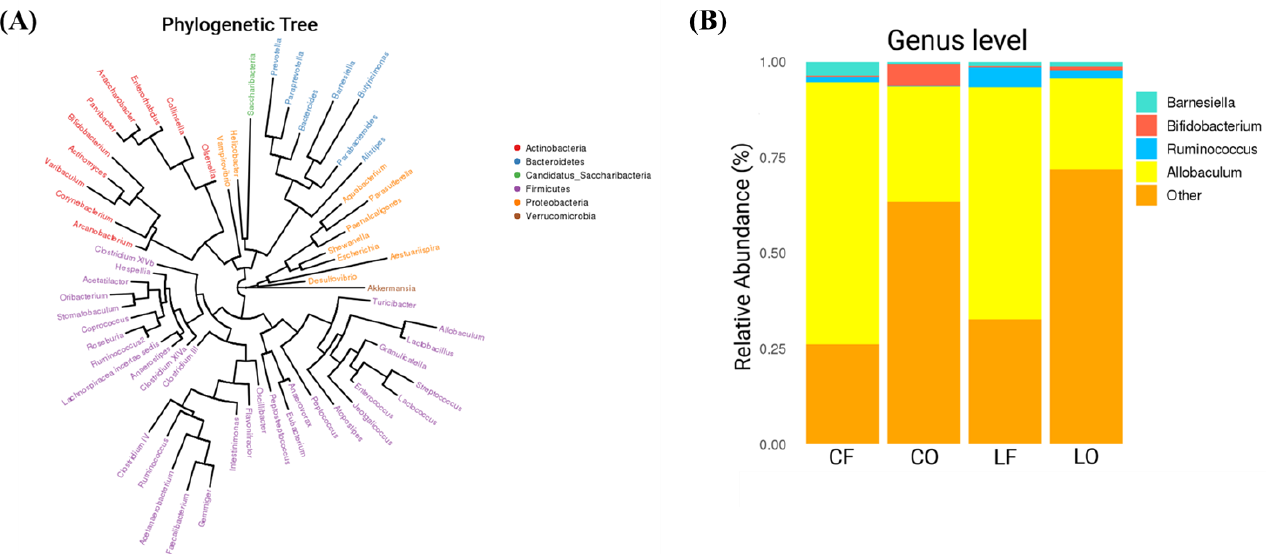
Figure 9. ( A ) Phylogenetic tree depicting the evolutionary relationship between the genera and phyla of bacteria found in this study. ( B ) Bar plot of genus relative abundance (%) between hamsters fed one of the four diets: CF, fresh corn oil; CO, oxidized corn oil; LF, fresh lard; LO, oxidized lard.